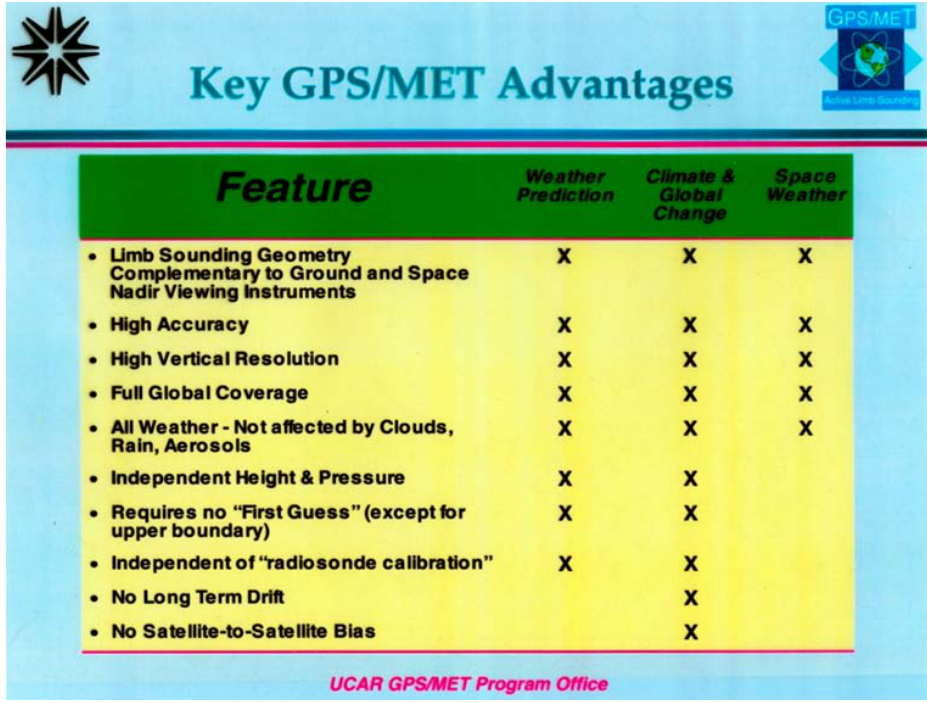
Table 1. An early (ca. 1995) table summarizing the characteristics of RO